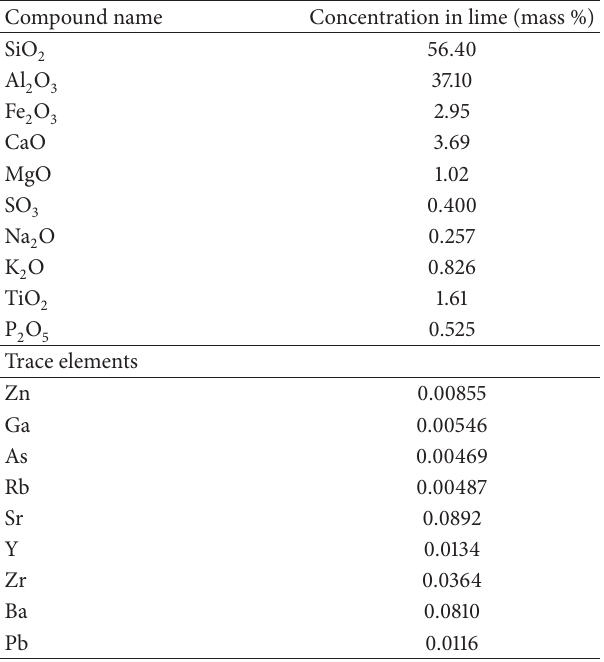
Table 7: Chemical composition of fly ash as determined by XRF.